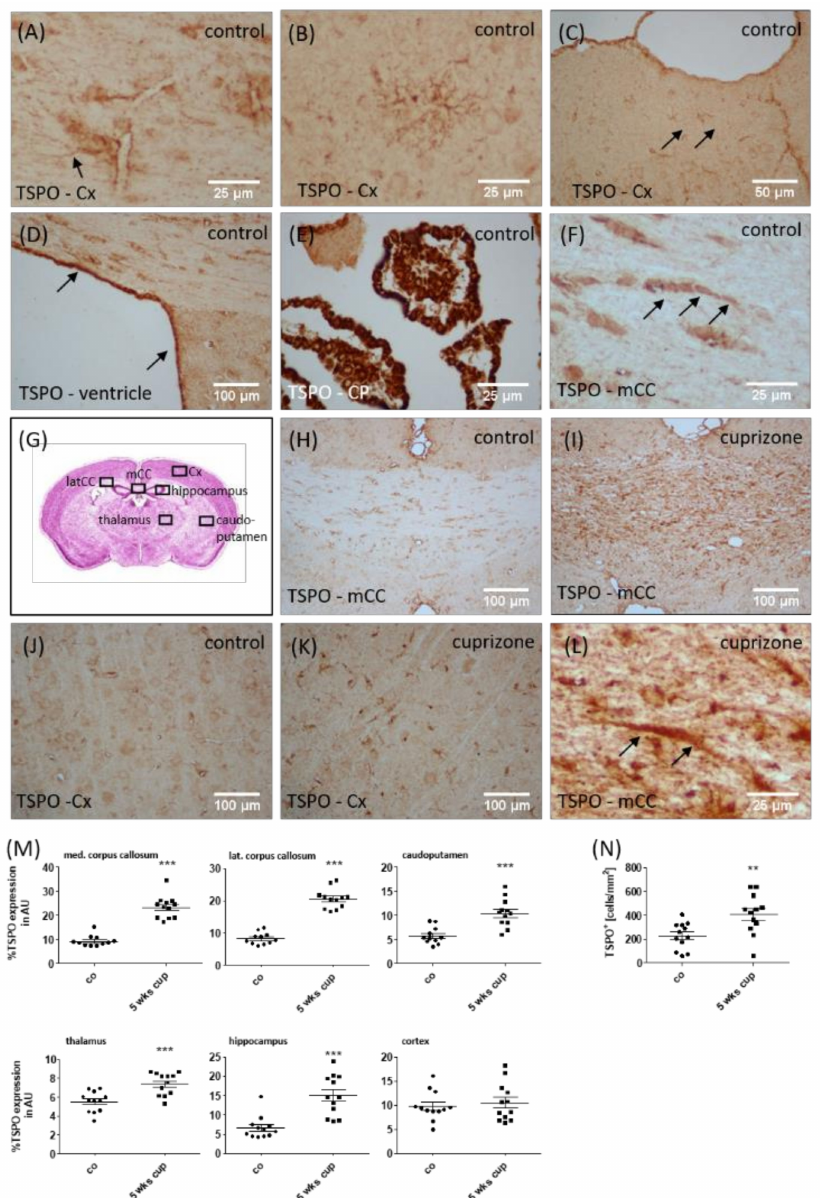
Figure 3. Expression of TSPO in cuprizone-intoxicated mice. The representative results of the anti-TSPO immunohistochemistry demonstrating the expression of TSPO in perivascular astrocytes (arrow in A ), oligodendrocyte progenitor cells ( B ), glia cells beneath the pial surface of the cortex ( C ), ependymal cells lining the lateral ventricles ( D ), choroid plexus cells ( E ) and interfascicular oligodendrocytes in the corpus callosum (arrows in F ). ( G ) Schematic illustration of the investigated regions. ( H – K ) The representative results of the anti-TSPO immunohistochemistry in the control or cuprizone-intoxicated mice. ( L ) A high-power view of an anti-TSPO + astrocyte (arrows) in the corpus callosum of cuprizone-intoxicated mice. ( M ) The densitometric quantification of the anti-TSPO staining intensity in different brain areas. ( N ) The quantification of anti-TSPO + cell densities in the somatosensory cortex of control and 5-week cuprizone-intoxicated mice, with representative pictures shown in ( J ) and ( K ). mCC (medial part of the corpus callosum); Cx (cortex); CP (choroid plexus). Differences between the groups were statistically tested using two-tailed t -test. Welsh correction was applied for the medial corpus callosum. * p < 0.05, ** p < 0.01, and *** p <